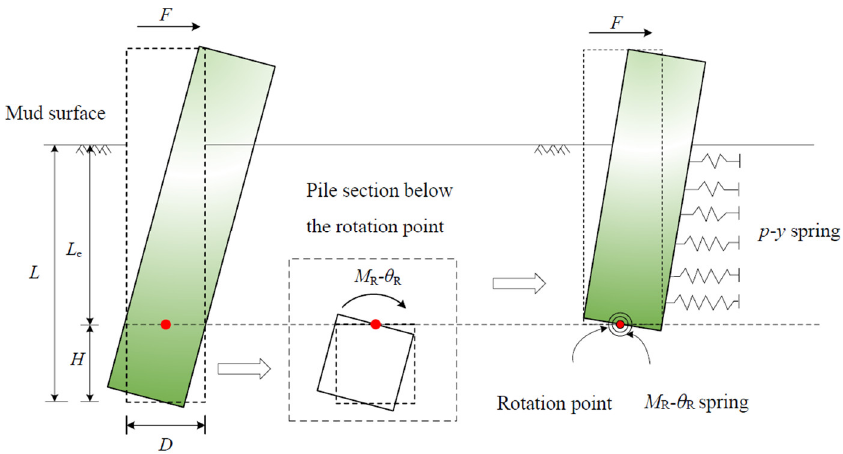
Figure 1. Simplified calculation model.